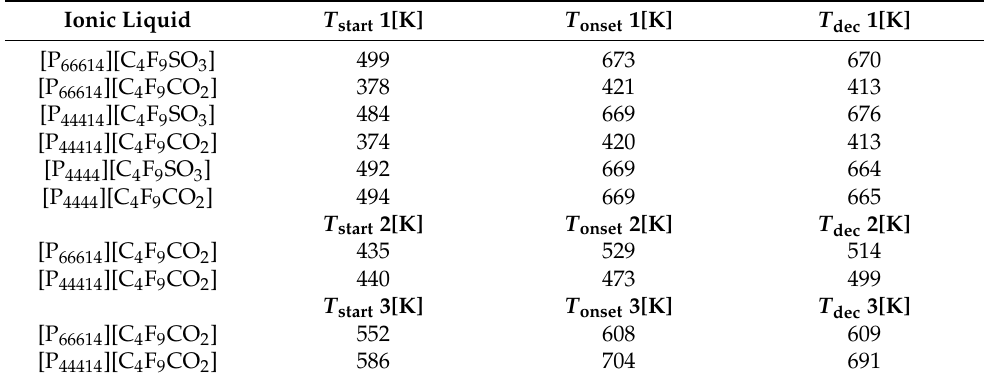
Table 3. Degradation properties: start temperature— T start ; onset temperature— T onset ; decomposition temperature— T dec , of the studied fluorinated ionic